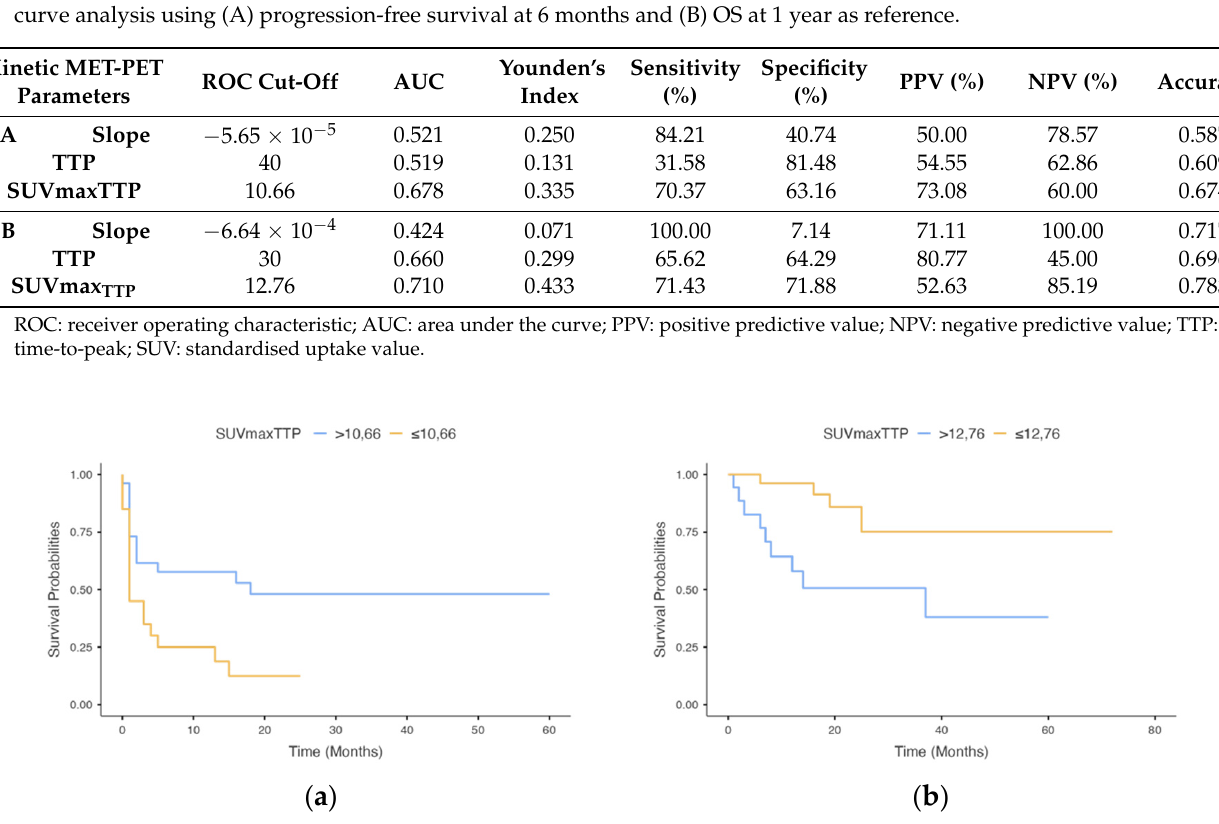
Figure 3. Kaplan–Meier estimates for progression-free survival ( a ) and overall survival ( b ) by SUVmax TTP ( p = 0.02 and p = 0.006, respectively).